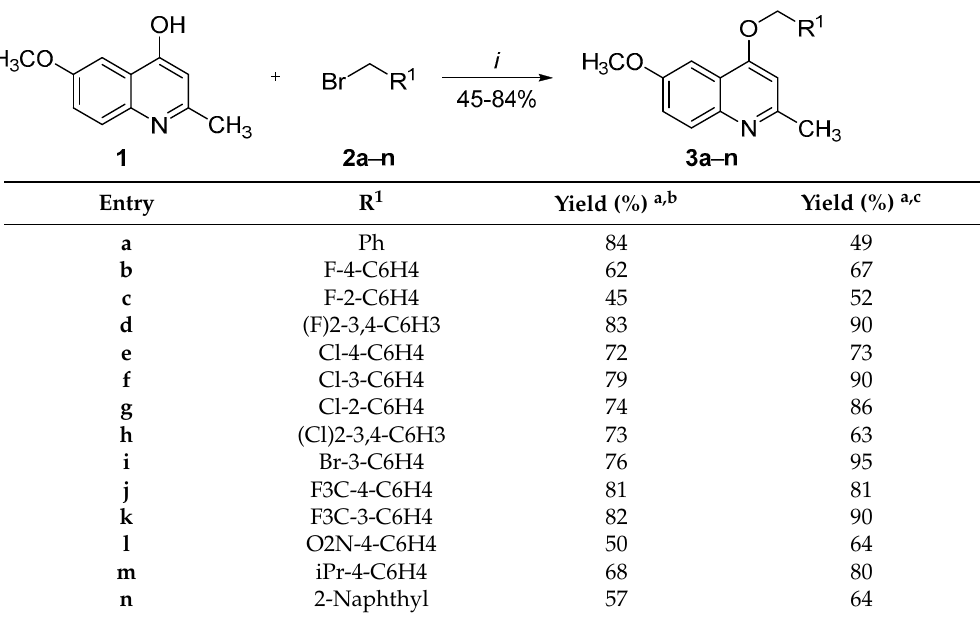
Table 2. Conditions: i = K 2 CO 3 , DMF, 15 min. a Isolated yields. b Ultrasound-assisted method. c Conventional stirring method